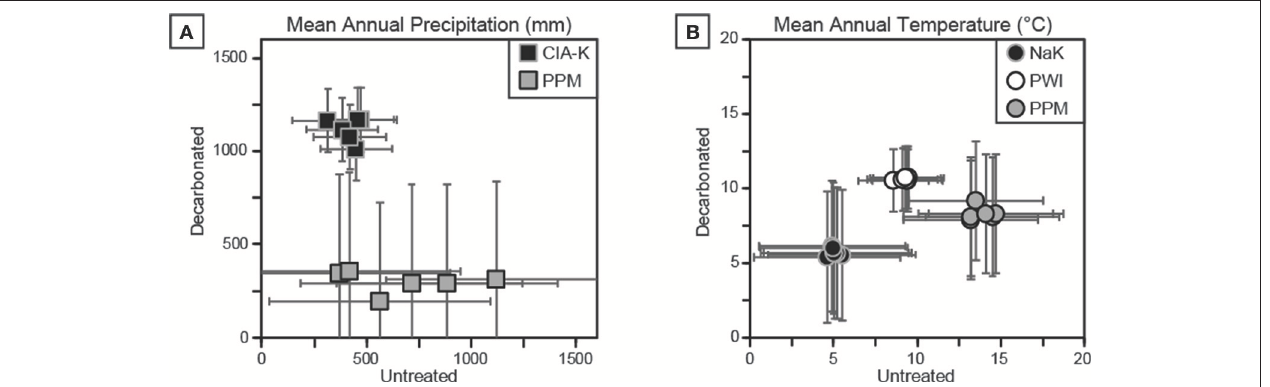
FIGURE 9 | Cross-plots of climate estimations for decarbonated and untreated samples. See Table 1 for details of each proxy. (A) Mean annual precipitation (MAP) estimates using CIA-K and PPM 1.0 show disparate results. MAP estimates using CIA-K are likely underestimated in untreated samples and overestimated in decarbonated samples, suggesting a dry subhumid climate (800–1,000mm), within error of PPM 1.0 estimates. (B) Mean annual temperature (MAT) estimates using NaK, PWI, and PPM 1.0 . Decarbonation had little effect on NaK and PWI estimates, but reduced PPM 1.0 output values. All estimates are interpreted to be too low for the geologic setting and sampled flora and fauna.